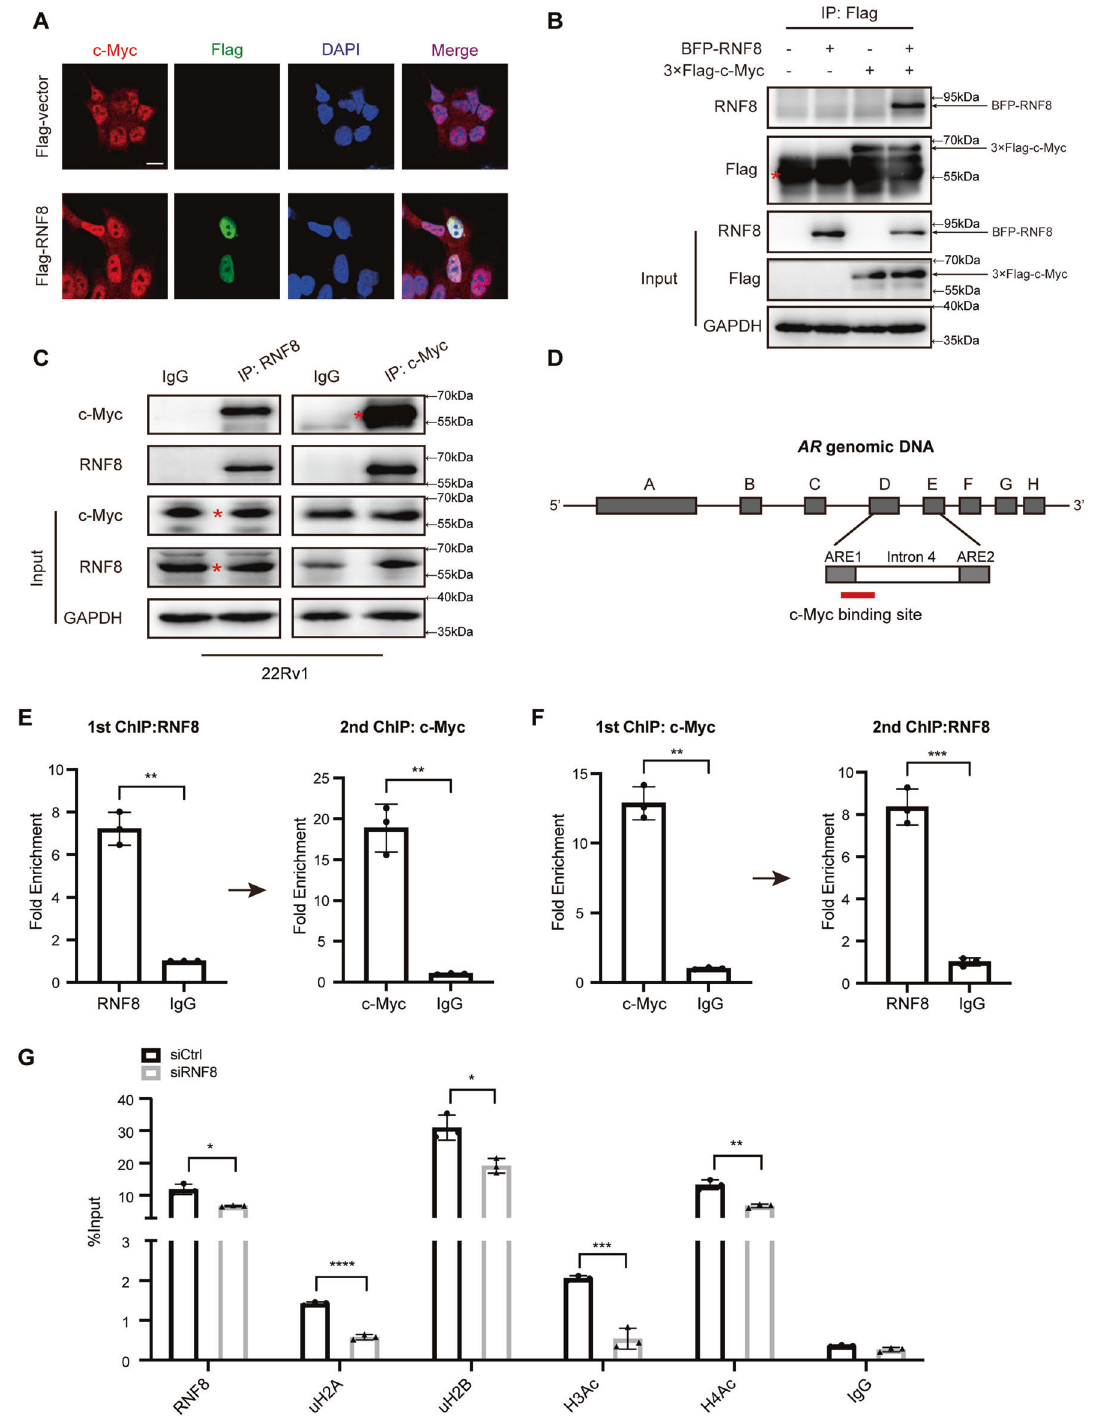
Fig. 3 RNF8 interacts with c-Myc and modulates histone modi fi cations at the c-Myc binding site in the AR gene. A Colocalization of Flag- RNF8 (green) and endogenous c-Myc (red) in 22Rv1 cells was detected by confocal. Scale bar, 10 µm. B The 22Rv1 cells were transfected with BFP-RNF8 and 3×Flag-c-Myc. The whole-cell lysates were performed immunoprecipitation by Flag M2 resin. BFP-RNF8 in the immunoprecipitated complex was detected by western blot using the RNF8 antibody. The asterisk indicates the heavy chain. C The 22Rv1 cell lysates were immunoprecipitated with RNF8 or c-Myc antibody followed by western blot. The asterisk indicates the speci fi c bands. D Schematic representation of the c-Myc binding site in the AR gene. The letters A to H indicate the exons of the AR gene. E , F ChIP re-IP assay was utilized to examine RNF8 and c-Myc forming a complex on the c-Myc binding site of the AR gene. The precipitated chromatin was analyzed by the qRT-PCR using primers fl anking the region in ( D ). G ChIP assay was performed in control and RNF8 silenced 22Rv1 cells by indicated antibodies. Data were presented as the fold enrichment relative to IgG control for ChIP re-IP (means ± SEM, n = 3); %input relative to the adjusted input for ChIP (means ± SEM, n = 3). * P < 0.05; ** P < 0.01; *** P < 0.001; **** P < 0.0001 (two-sided unpaired t -test).